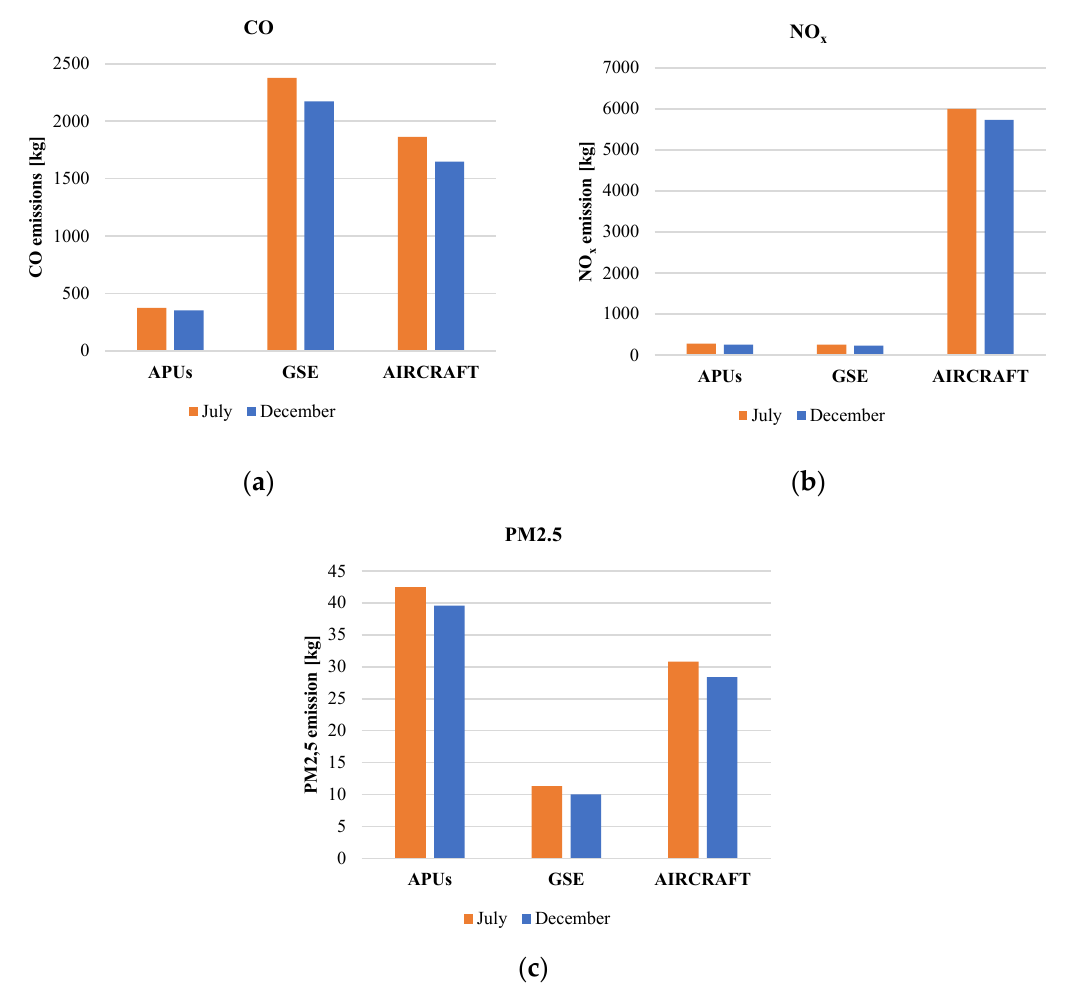
Figure 2. CO ( a ), NO x ( b ) and PM2.5 ( c ) emissions by APU, GSE and aircraft.